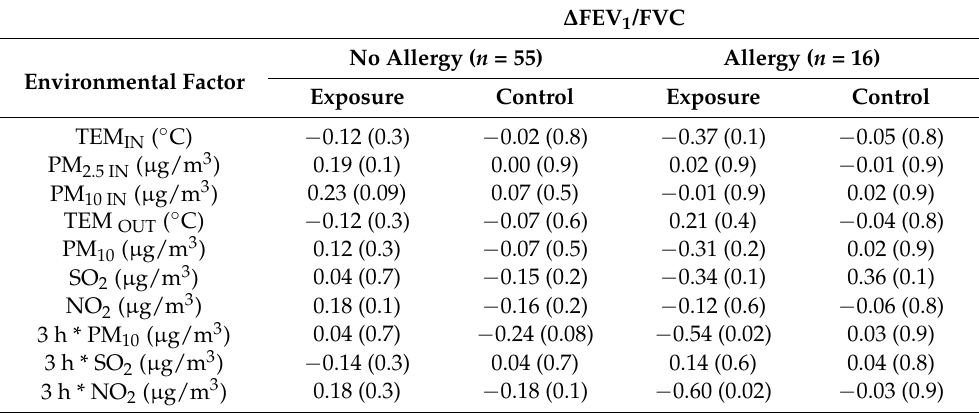
Table 6. Correlations between post-exercise change in FEV 1 /FVC and environmental conditions (results of Spearman rank test; the table presents results as R ( p -value)). ∆ FEV 1 /FVC No Allergy ( n = 55) Allergy ( n = 16) Environmental Factor Exposure Control Exposure